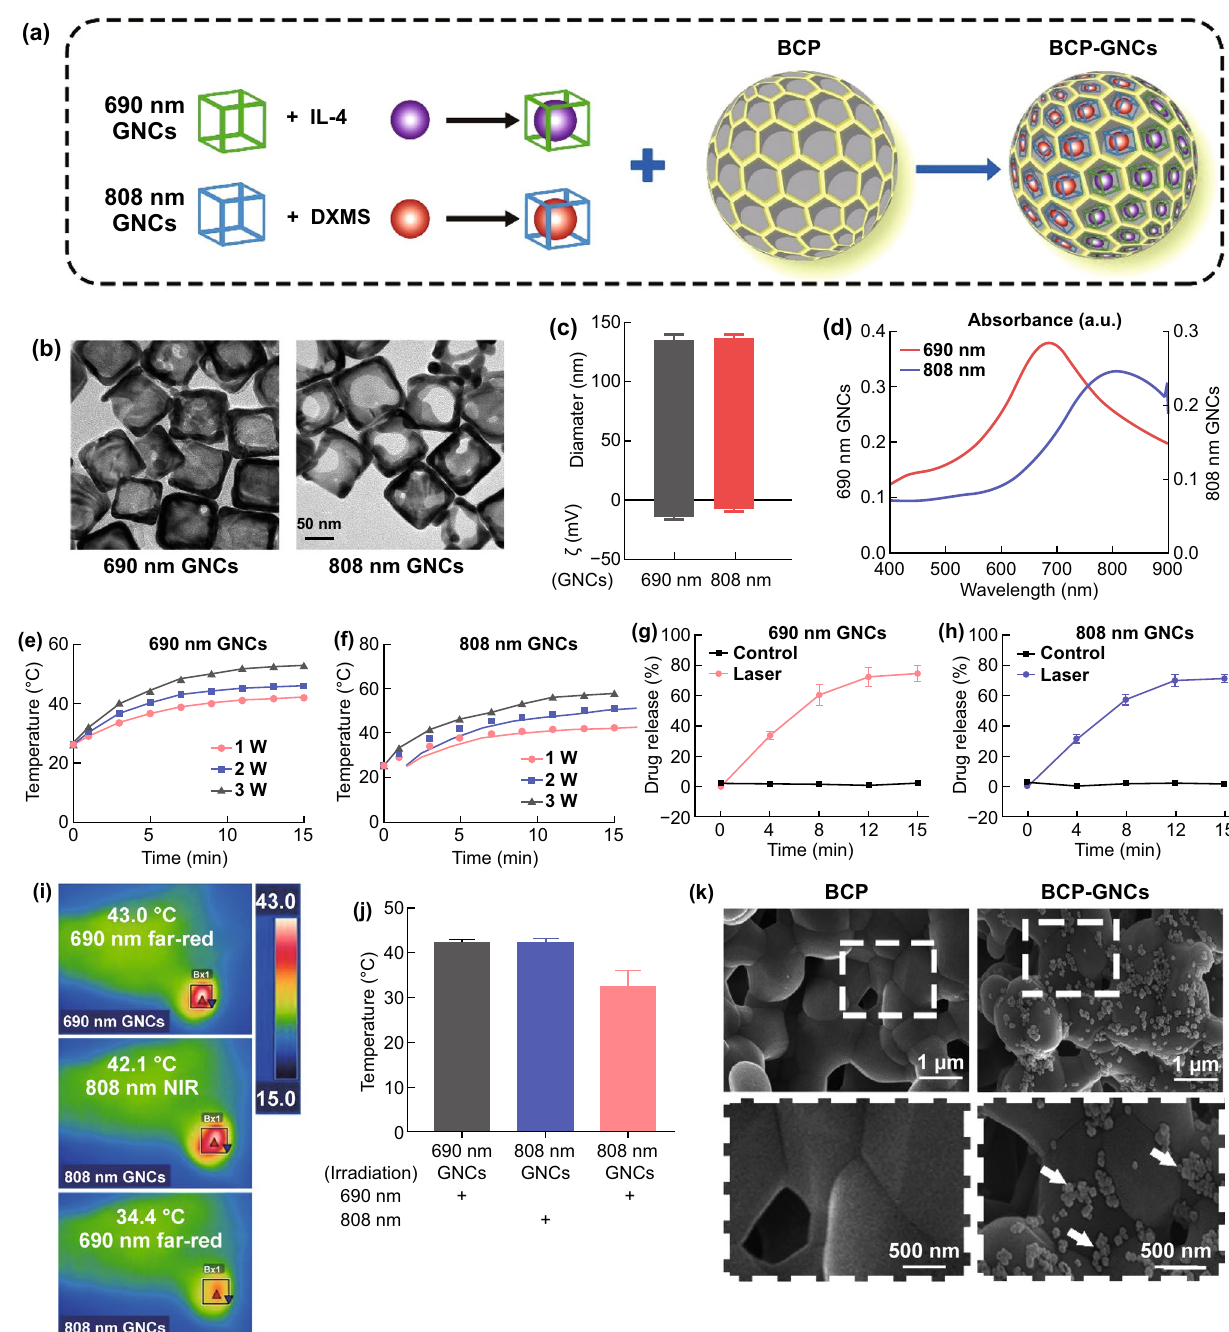
Fig. 4 a Schematic diagram of synthetic process of BCP-GNCs. b TEM images of 690 nm GNCs and 808 nm GNCs (bar = 50 nm). c DLS measurements of 690 nm GNCs and 808 nm GNCs hydrodynamic size (diameter) and zeta potential (ζ). n = 3. d Absorbance spectra of 690 nm GNCs and 808 nm GNCs. e, f Temperature increase of 690 nm GNCs and 808 nm GNCs under irradiation (690 nm far-red or 808 nm NIR) at varying power densities (1 W, 2 W, 3 W). g, h The fluorescein methylene blue (MB) was used as a model drug to load into GNCs. 690 nm far- red or 808 nm NIR controlled release of fluorescein MB load in 690 nm GNCs and 808 nm GNCs. i Infrared thermal images of 690 nm GNCs and 808 nm GNCs under the 690 nm far-red and 808 nm NIR in vivo. j Semiquantification of the temperature in infrared thermal images in ( i ). k SEM images of GNCs compositing BCP (bar = 500